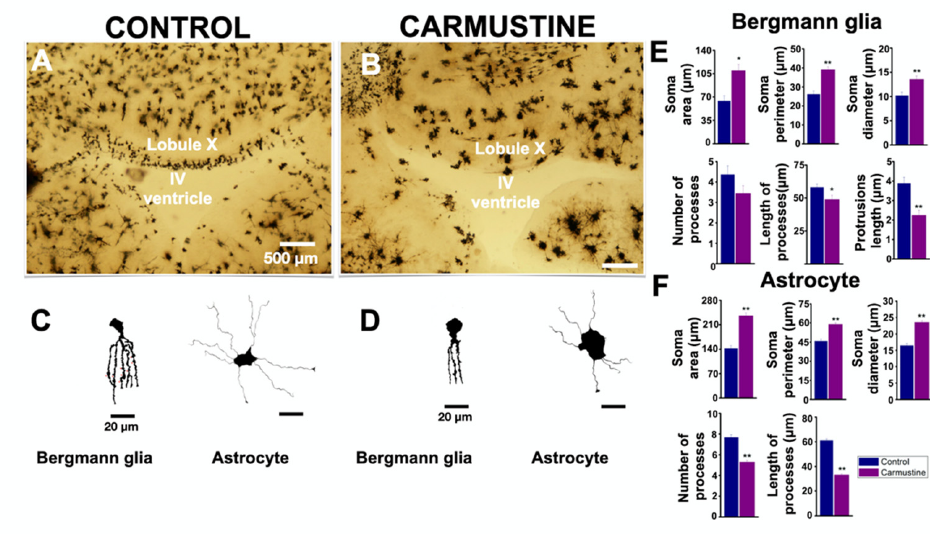
Figure 3. Carmustine treatment reduced morphological complexity of glial cells. ( A ). Coronal section at the level of lobule X of the cerebellum processed by Golgi-Cox staining. ( B ). A sample image of the same region showing a cortical dysplasia. Notice the malformation of the shape of the fourth ventricle. ( C , D ). Representative drawings with camera lucida of a Bergmann cell of lobule X and an astrocyte from cerebellar cortex, control and carmustine respectively. Complexity and extension of the astrocyte processes are observed in the control group, which contrasts with the carmustine-treated group, as fewer and diffuse processes are observed, as well as an increase in the size of the soma. ( E , F ). Comparative analysis between the control and the carmustine-treated groups (1 to 3 BG cells were analyzed from each experiment; Control n = 6, Carmustine n = 6 and 6 to 8 astrocyte cells were analyzed from each experiment; Control n = 6, Carmustine n = 6). Data are represented as the mean ± the standard error of the mean. * indicates significant difference ( p < 0.05) and ** indicates significant difference ( p < 0.001) both compared to the control group.